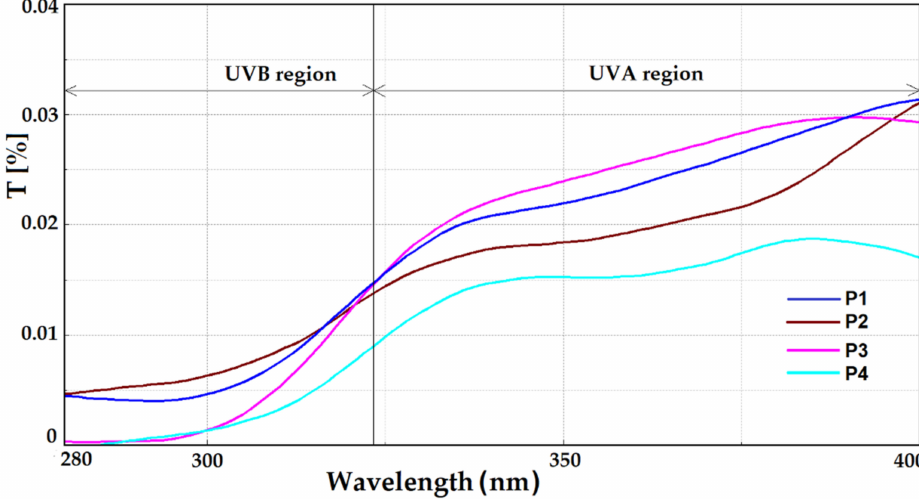
Figure 11. The transmittance spectra of coated